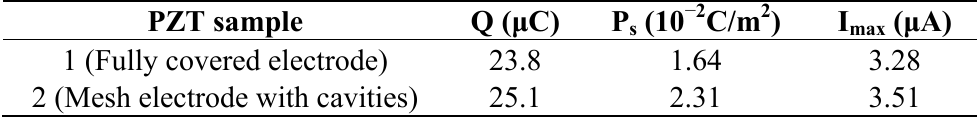
Table 4. Experimental output for the PZT pyroelectric